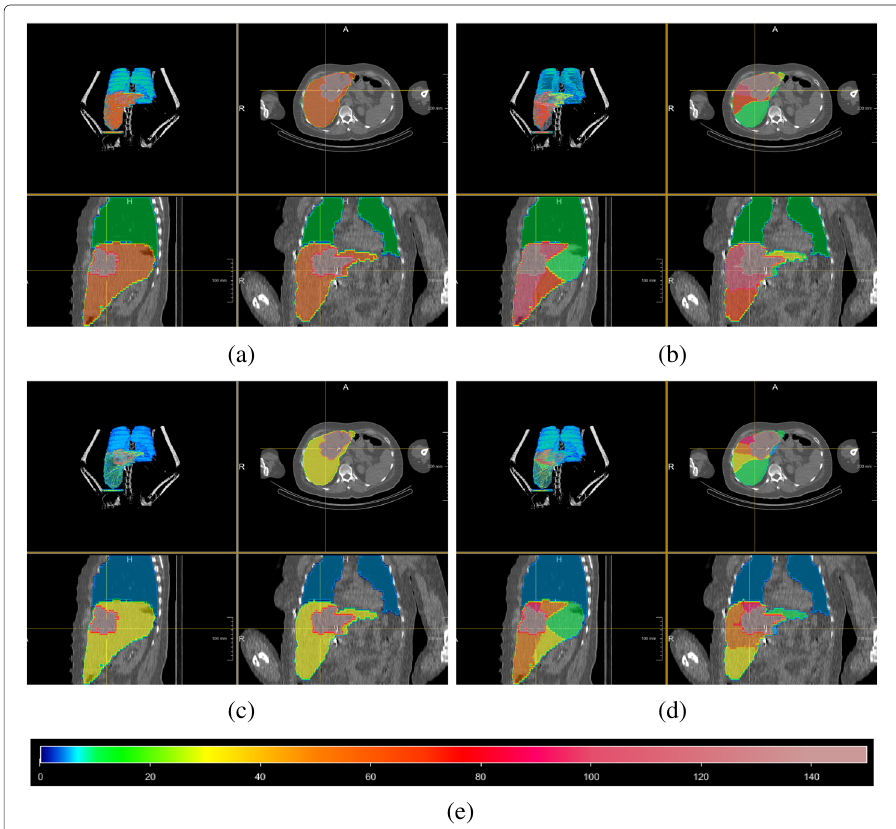
Fig. 2 Visualization of dose distribution for Pat1 using PM (left) and TM (right) and normal liver thresholds T 1 in the first row and T 2 in the second row. The dose color bar, relating color to dose values, is given below. Each quartet shows axial, sagittal, coronal, and anterior 3D view. a PM activity and dose calculation using T 1 . b TM activity and dose calculation using T 1 . c PM activity and dose calculation using T 2 . d TM activity and dose calculation using T 2 . e Dose color bar in